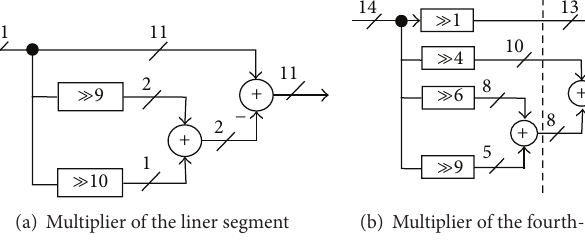
Figure 9: Constant coefficient